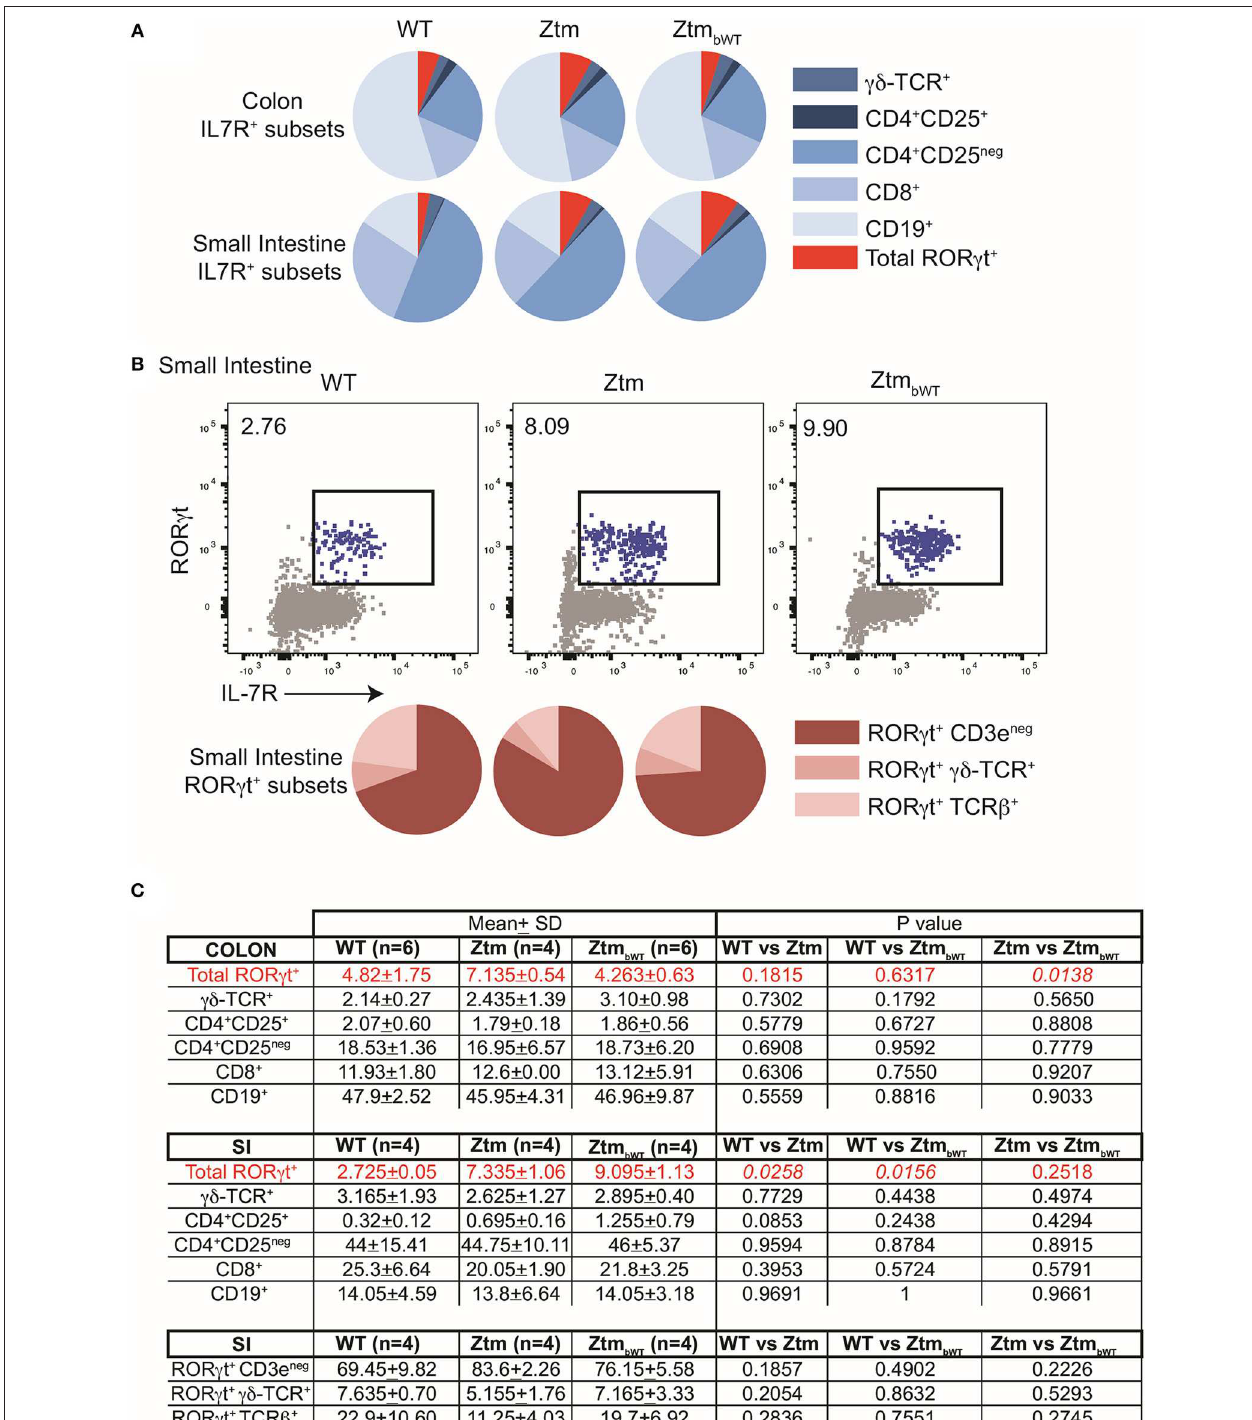
FIGURE 5 | Distribution of immune cell subsets in colon and SI of WT and Ztm/Ztm bWT mice. Lamina propria and epithelial compartment lymphocytes from the colon (WT n = 6; Ztm n = 4; Ztm bWT n = 6) and small intestine (SI) (WT n = 4; Ztm n = 4; Ztm bWT n = 4) of 35 days old mice were analyzed by flow cytometry. (A) Pie chart representation of distribution of indicated IL7R + subsets in colon (Top row) and small intestine (SI) (Bottom Row). (B) (Top row) Representative flow cytometry dot plots show expression of IL-7R (x-axis) and ROR γ t (y-axis) in lymphocytes from the SI. (Bottom Row) Pie chart representation of distribution of indicated IL7R + ROR γ t + subsets in SI. (C) Summary of distribution of immune cell subsets in colon and SI. Mean, SD, and p -values are indicated. Unpaired parametric t -test was used for comparisons between the 2 groups with significance set at p < 0.05.